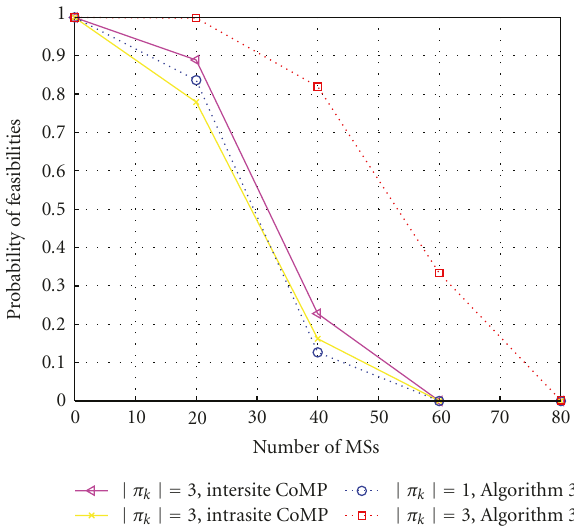
Figure 8: Comparison of probabilities of feasibility of intra-site, inter-site cooperation and proposed adaptive reception schemes. Again SINR constraint is